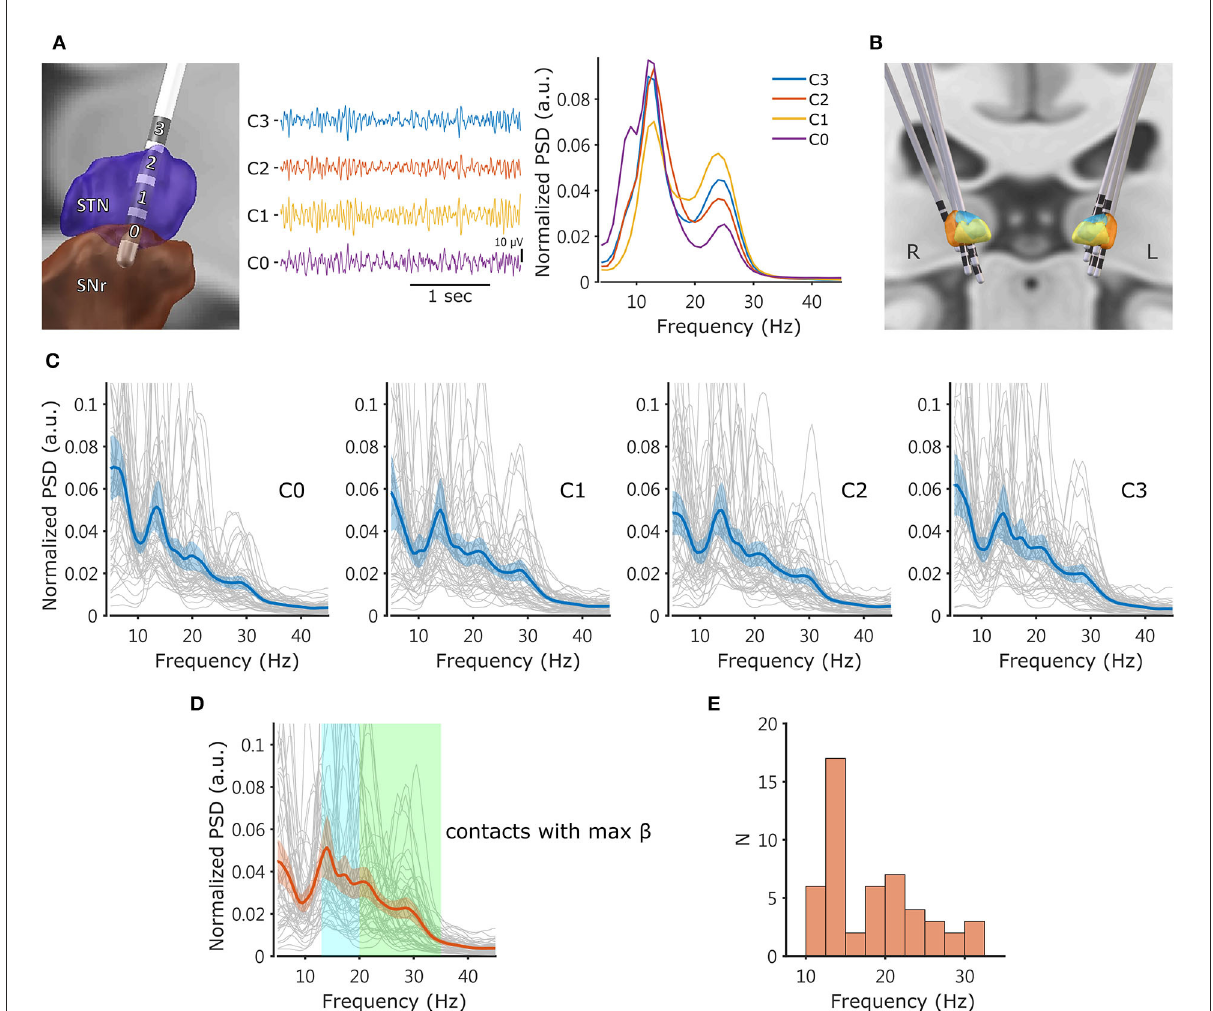
FIGURE1 Example of DBS lead location and LFP. (A) Left: Lead-DBS reconstruction of an example lead located on the left STN of patient 14. Middle: The common average referenced unipolar LFPs from the same macroelectrode. Right: The normalized power spectra derived from the LFPs. Spectral peaks were observed at ∼ 13Hz and 24Hz. The power spectra were generated using Welch’s method and normalized so that the Y scale represents the spectral power relative to the total power (5–55Hz and 65–95Hz) in each 1-Hz bin. (B) Lead-DBS reconstruction of five patients’ DBS leads, revealing that the electrodes were appropriately located at the sensorimotor STN. (C) Power spectra from every contact of all analyzed electrodes ( N = 50 sides). Each thin line is an individual power spectrum. The thick solid line in each plot represents the averaged PSD, and the colored shadow indicates the 95% confidence interval of mean. (D) Power spectra from the contacts with the maximum normalized broad-band β power (13–35Hz). The transparent rectangles in cyan and green mark the low- β (13–20Hz) and high- β (20–35Hz) frequencies, respectively. (E) Distribution of the peak frequencies (the local maximum within the 10–35Hz range) of the power spectra from the contacts with the maximum broad-band β . LFP, local field potential; STN, subthalamic nucleus; SNr, substantia nigra pars reticulata; PSD, power spectral